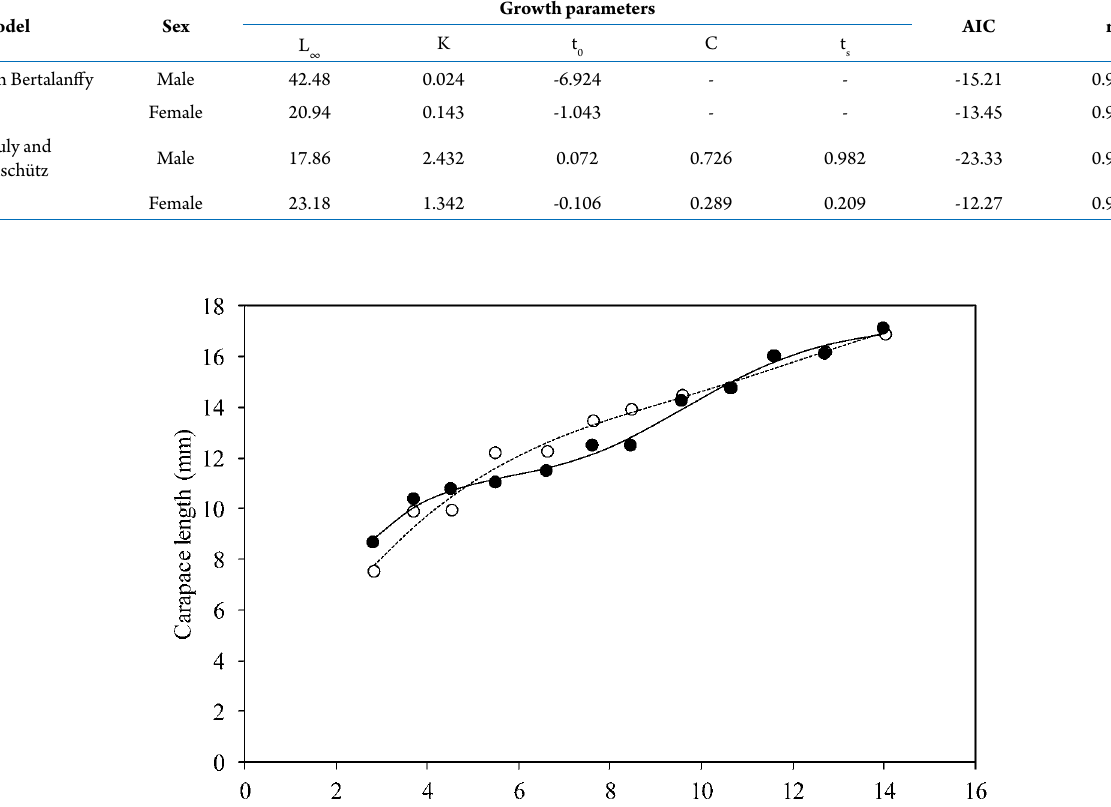
= theoretical age at zero length, C = intensity of seasonal growth 0